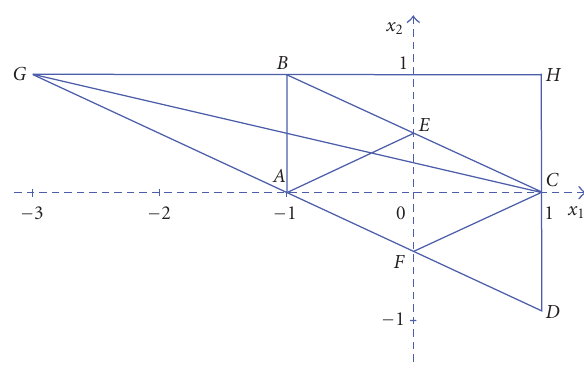
Figure 2.1. Di ff erent stability regions.